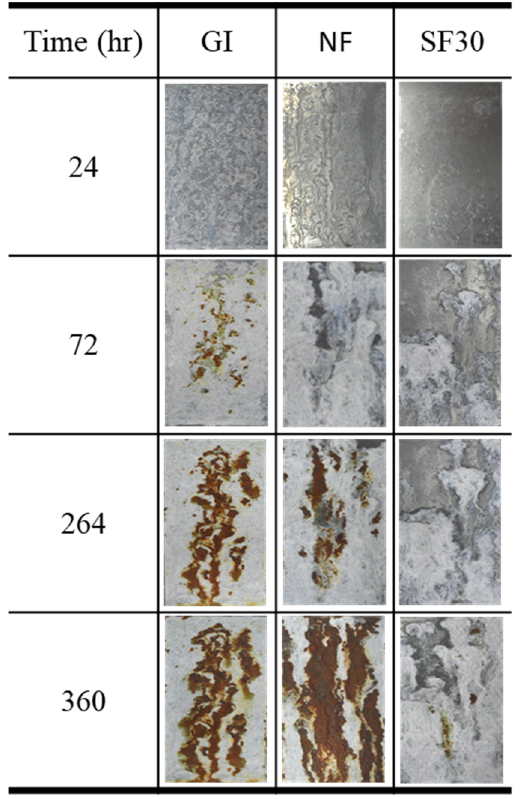
Figure 9. Red rust formation in the GI and Zn–1Mg–1Al coatings with different flux compositions.